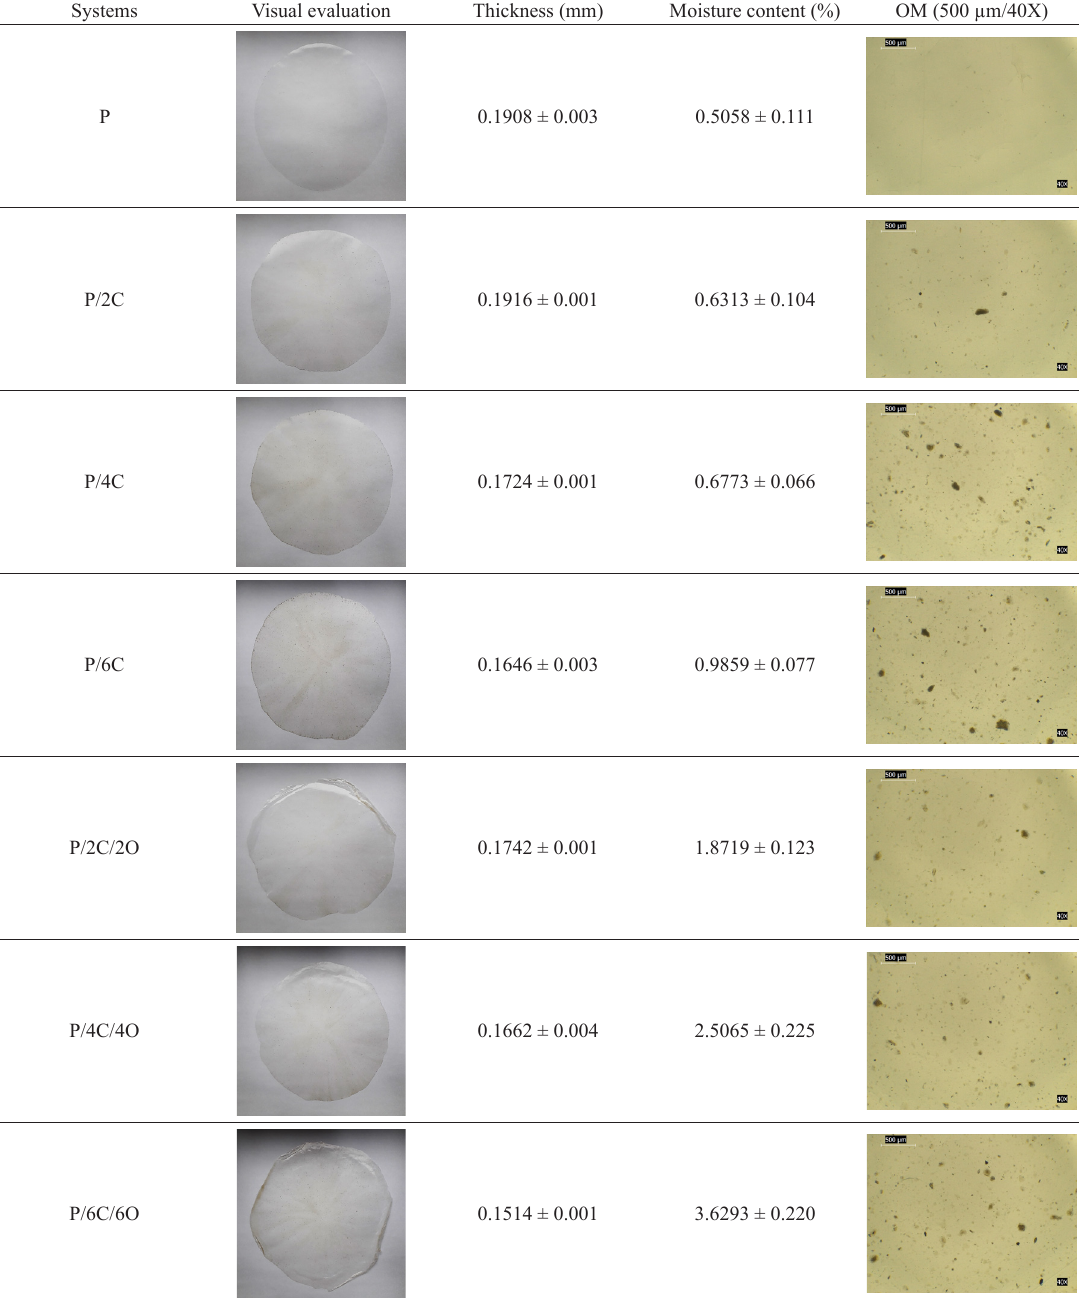
Table 2. Visual evaluation, thickness, moisture content and OM of the films produced.